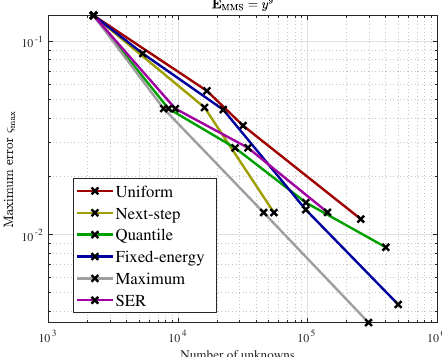
Figure 8. Convergence of the maximum value of the error for (13).